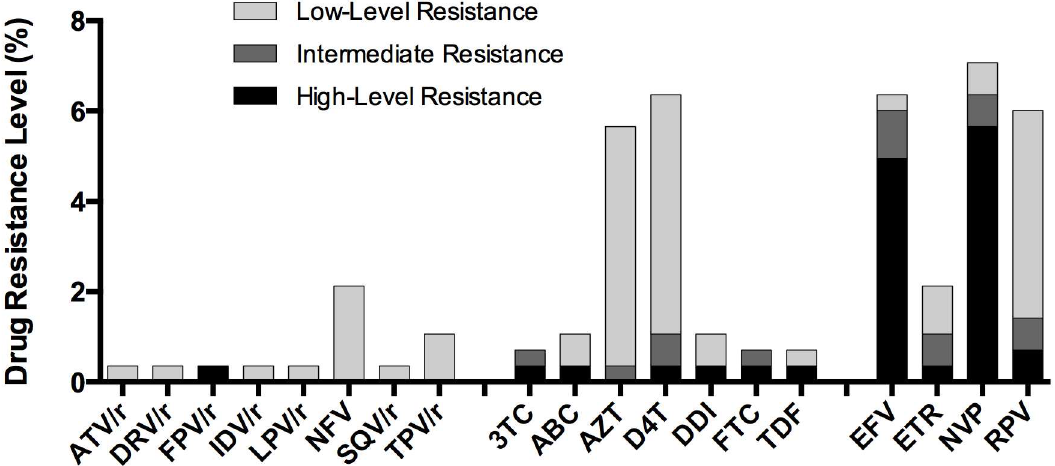
Fig 3. PDR levels per antiretroviral drug. PDR levels per drug were estimated using the Stanford HIVdb tool, from Sanger sequences, and classified accordingto the Stanford Score (SS) as high: SS (cid:21) 60, intermediate: SS 30–59, or low: